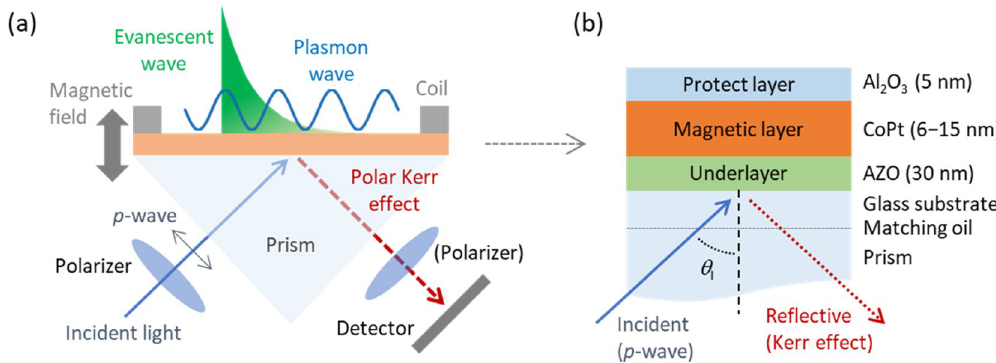
Figure 1. Schematics of ( a ) measurement setup for polar Kerr excitation geometry and ( b ) sample structure of MO–SPR elements. SPPs are excited in the Kretschmann (or attenuated total reflection) configuration